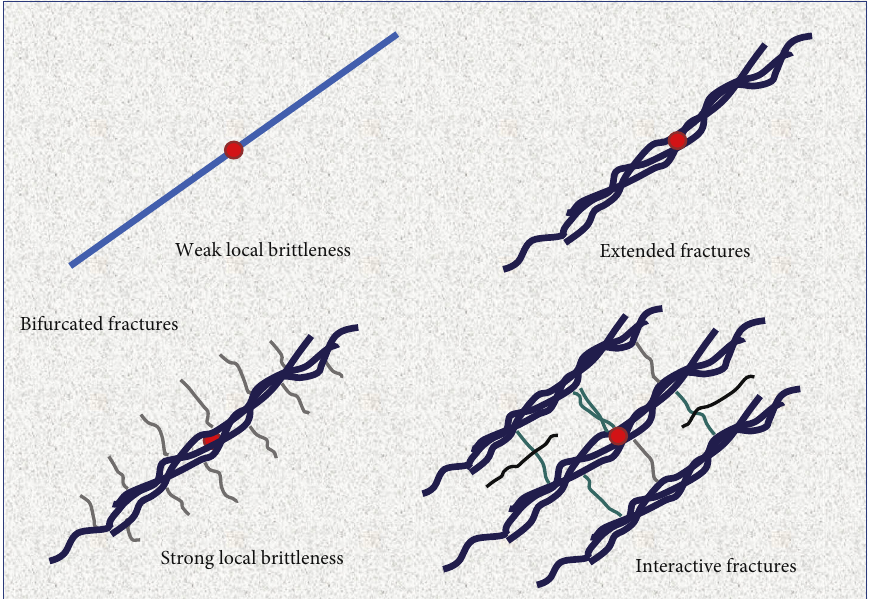
Figure 2: Schematic diagram of fracture evolution in di ff erent brittle regions of a rock mass. Table 1: The determination result of core mineral compositions and mechanical